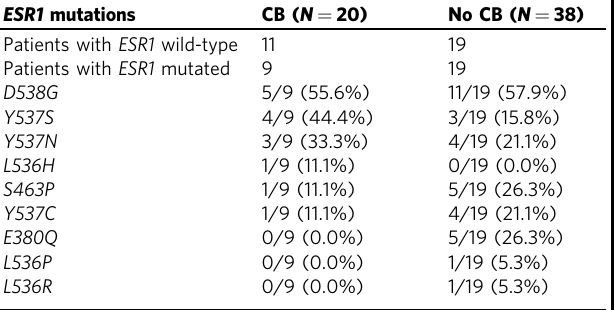
Table 6 ESR1 mutation status at baseline in patients from the biomarker population (Parts A and B excluding the pharmacodynamically inactive amcenestrant QD 20-mg dose) with available data for baseline ESR1 mutational analysis in cfDNA detected by ddPCR ( n = 58), and analyzed by those who subsequently achieved clinical bene fi t versus no bene fi t during amcenestrant